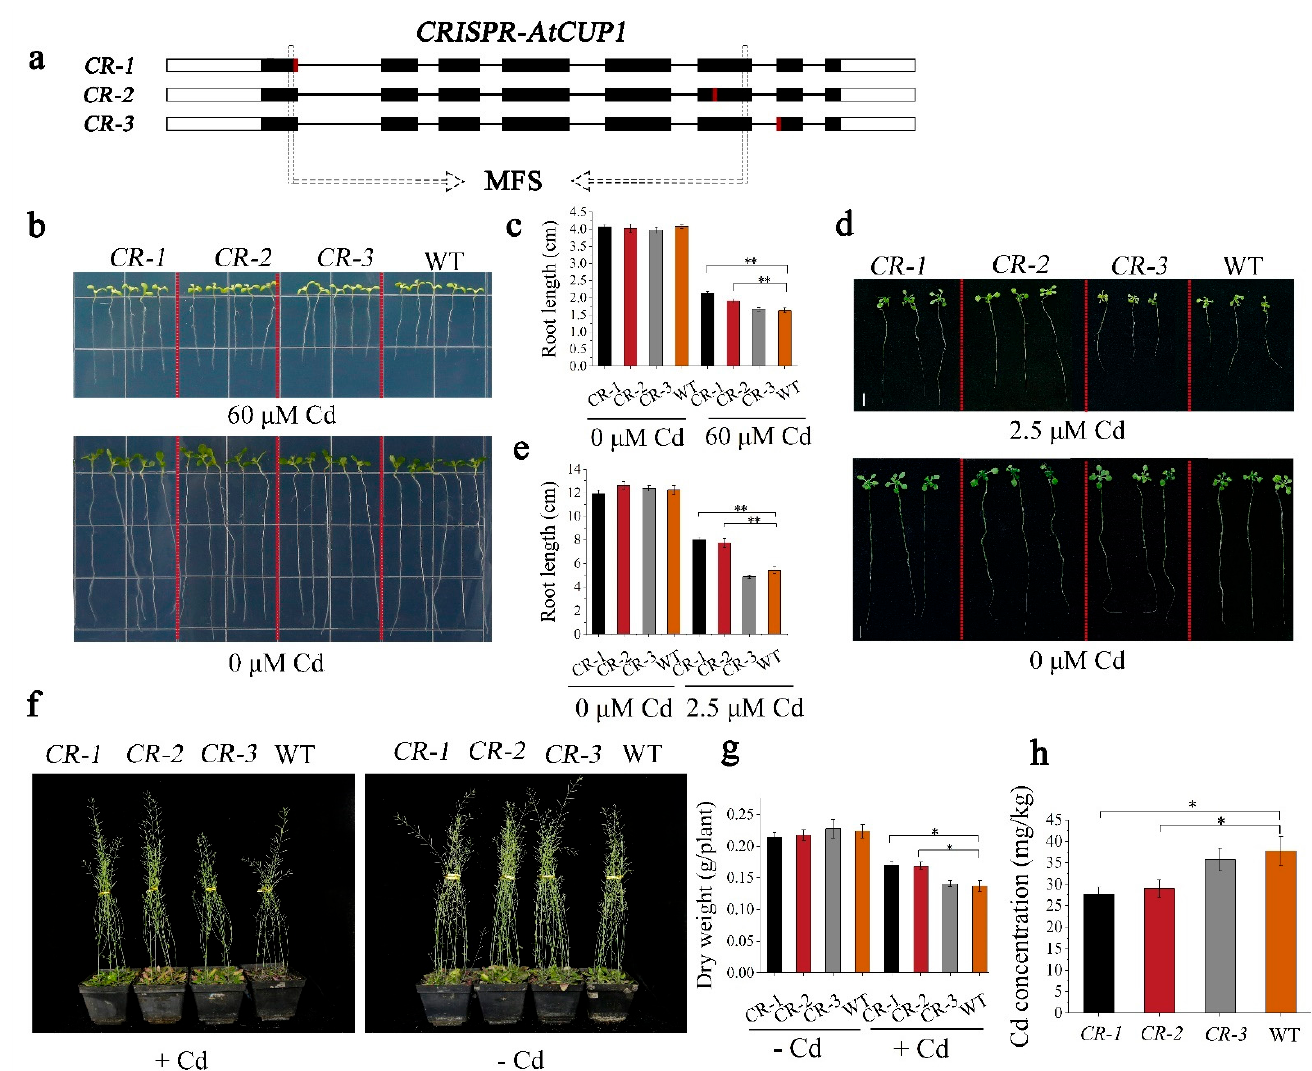
Figure 4. Disruption of the AtCUP1 domain enhanced Cd tolerance and reduced Cd accumulation. ( a ) Schematic diagram of three CRISPR-AtCUP1 lines. The rectangle inside the dotted line indicates the MFS domain. The black rectangle marks the exon of AtCUP1 , the straight line shows the intron of AtCUP1 , and the red box indicates the location of the sgRNA. ( b,c ) Growth and root length measurements of three CRISPR-AtCUP1 lines growing in 1/2 MS medium containing 0 or 60 μ M Cd. ( d,e ) Growth and root length measurements of three CRISPR-AtCUP1 lines cultured in hydroponic solution containing 0 or 2.5 μ M Cd. ( f ) Growth status of three CRISPR-AtCUP1 lines grown in pot soil with or without Cd. ( g , h ) Dry weight and Cd concentration of three CRISPR-AtCUP1 lines grown in pot soil with and without Cd. Three independent experiments, each in triplicate, were performed for each measurement. The error bar represents standard deviation. Statistical analysis was performed by Student’s t- test (* p < 0.05).